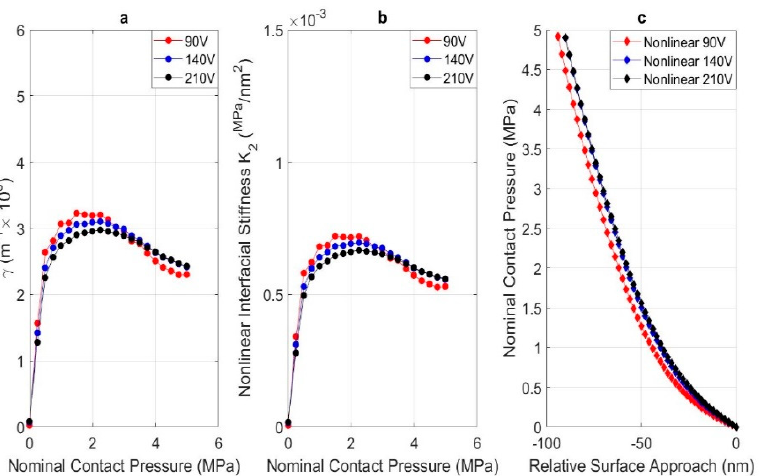
Figure 9. The influence of nominal contact pressure p 0 : ( a ) second order nonlinear parameter for the reflected ultrasound from the interface γ ; ( b ) nonlinear interfacial stiffness; ( c ) pressure-relative surface approach derived from the nonlinear interfacial stiffness at incidents amplitude excitations of 90 V , 140 V and 210 V .